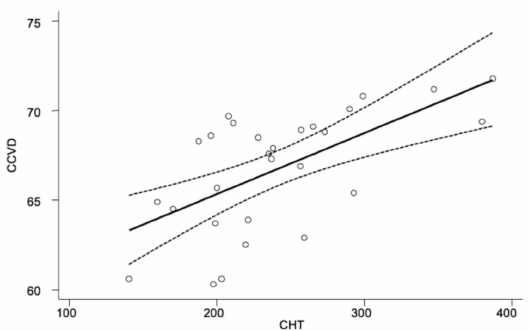
Figure 5. Linear regression analysis evaluating the association between CCVD and CHT in cases and controls. Dotted lines represent 95%CI. R 2 = 0.39; p < 0.001. CCVD (choriocapillary vessel density, in percentage). CHT (choroidal thickness, in